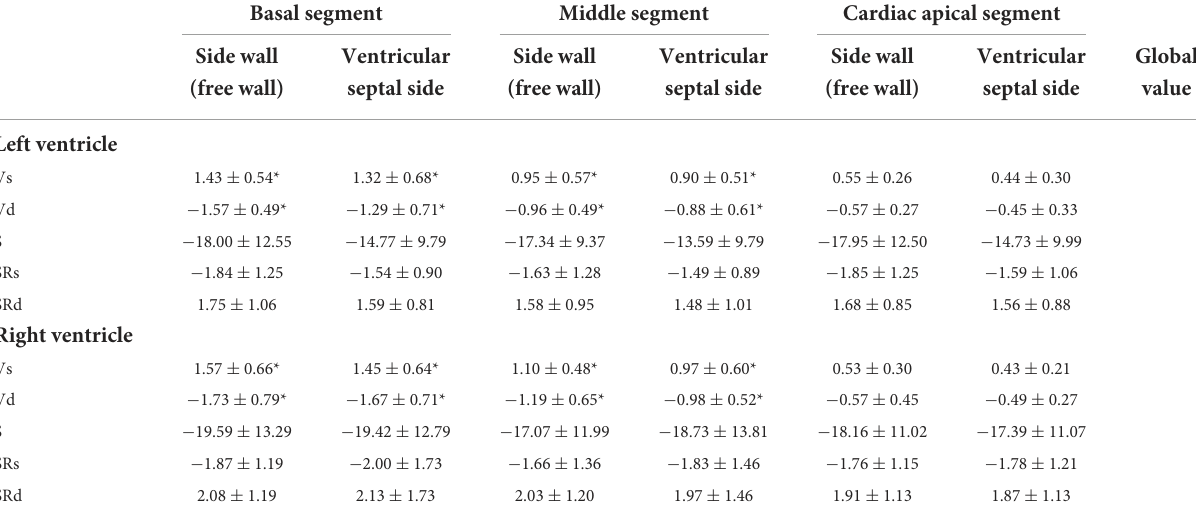
TABLE 3 Six segments and global velocity, strain and strain rate of left and right ventricular myocardium of normal fetal heart in both systolic and diastolic phases. Basal segment Middle segment Cardiac apical segment Side wall Side wall Side wall Global (free wall) septal side (free wall) septal side (free wall) septal side